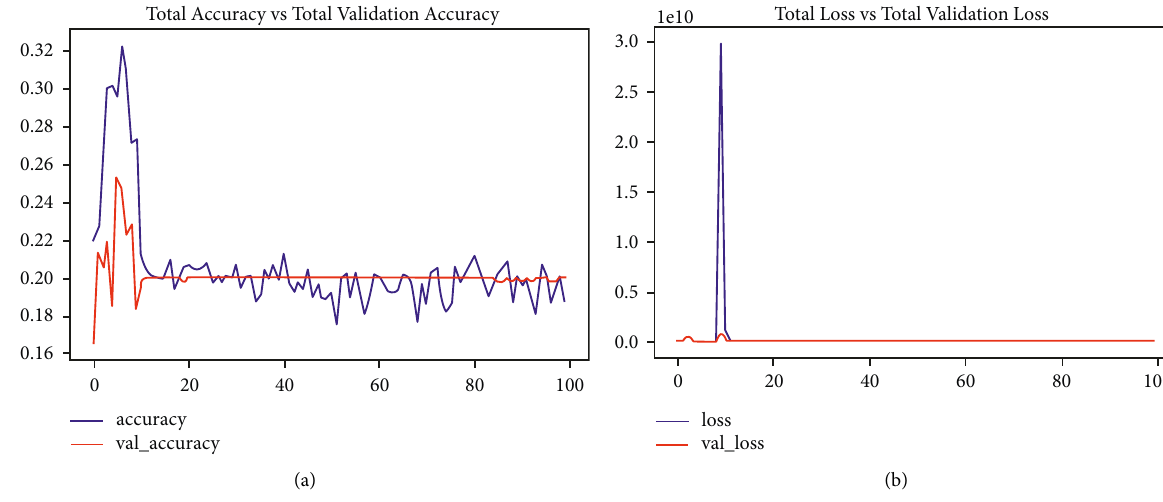
Figure 5: Performance measures of training and testing datasets: (a) accuracies and (b) loss.